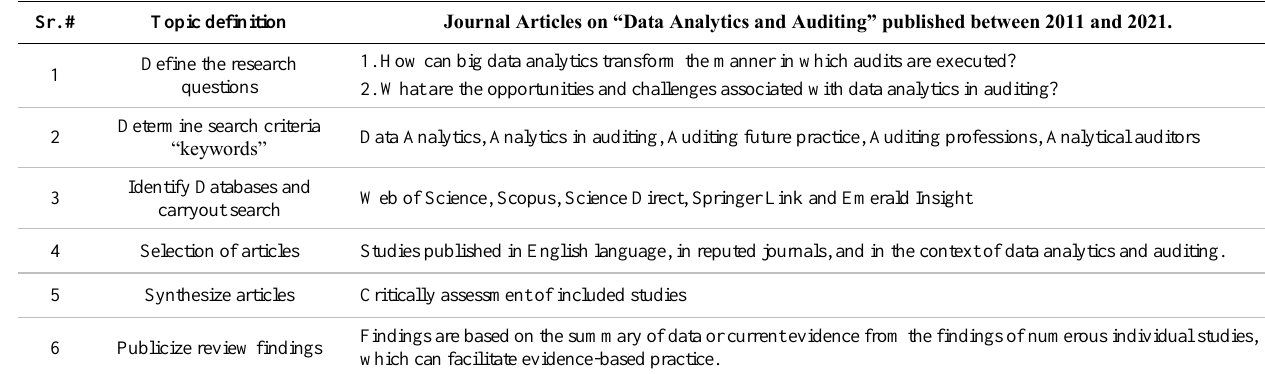
Table 1. Systematic Literature Review Process using PRISMA